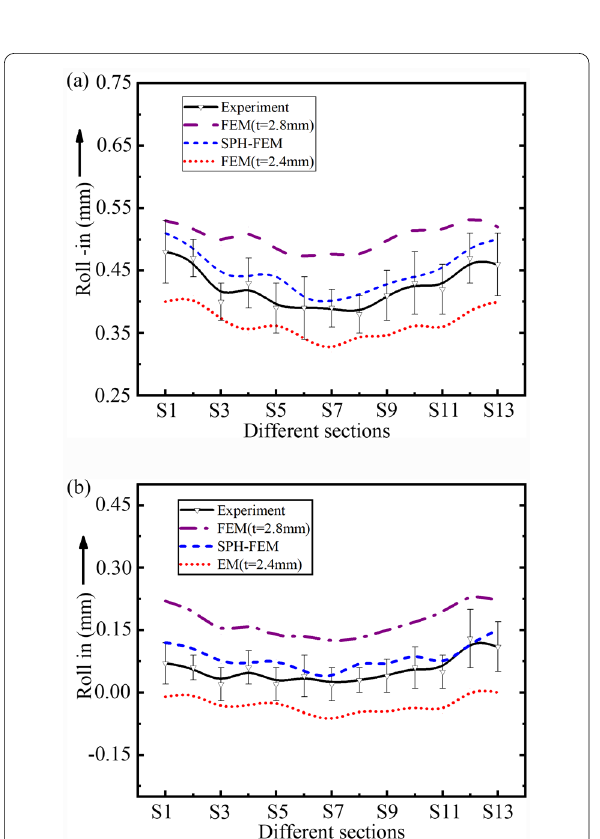
Figure 9 Changes of roll in/out at different sections: (a) Pre hemming, (b) Final hemming